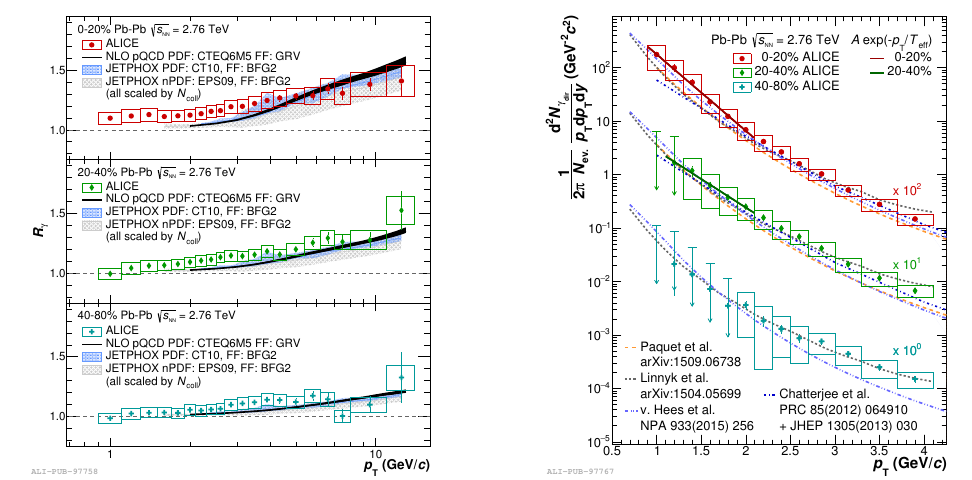
Figure 3. Left: photon double ratio R γ in three centrality classes in Pb–Pb collisions at √ s NN = 2 . 76 TeV. Right: direct photon spectra measured in three centrality classes in Pb–Pb collisions at √ s NN = 2 . 76 TeV compared to predictions of several